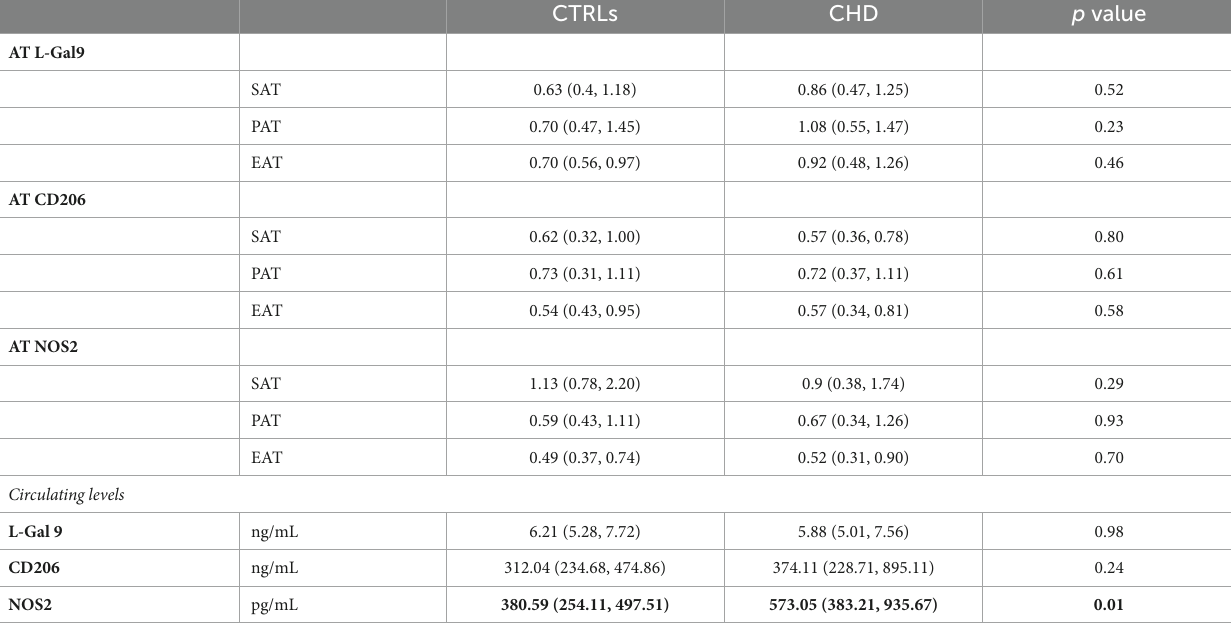
TABLE 2 AT expression and serum concentration of macrophage phenotype regulating parameters in CHD and control patients. CTRLs CHD p